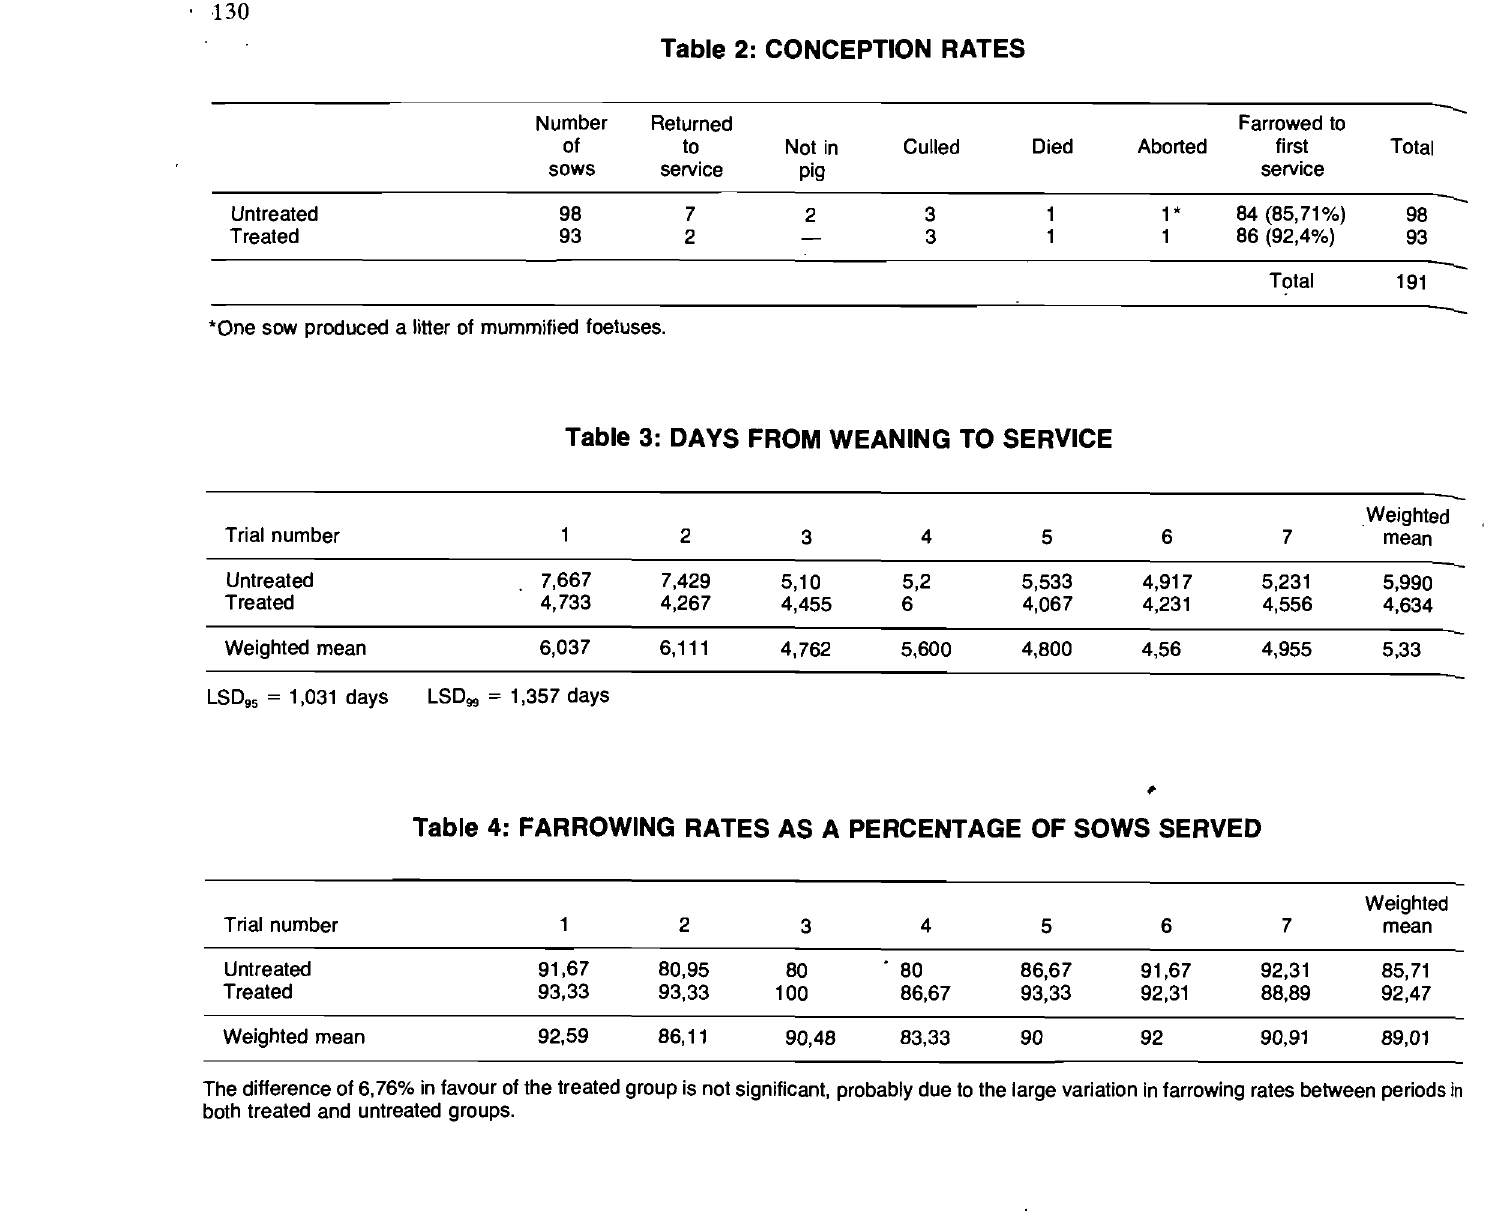
Table 2: CONCEPTION RATES